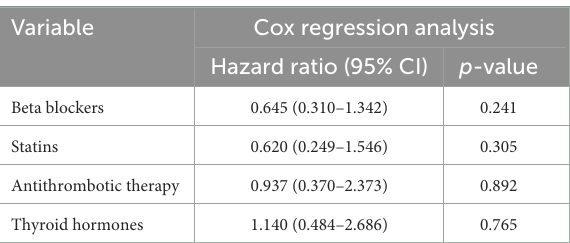
TABLE 3 Longitudinal outcome analysis: Cox regression analysis for medication intake and cumulative 5-year (re-)bleeding risk (age and sex